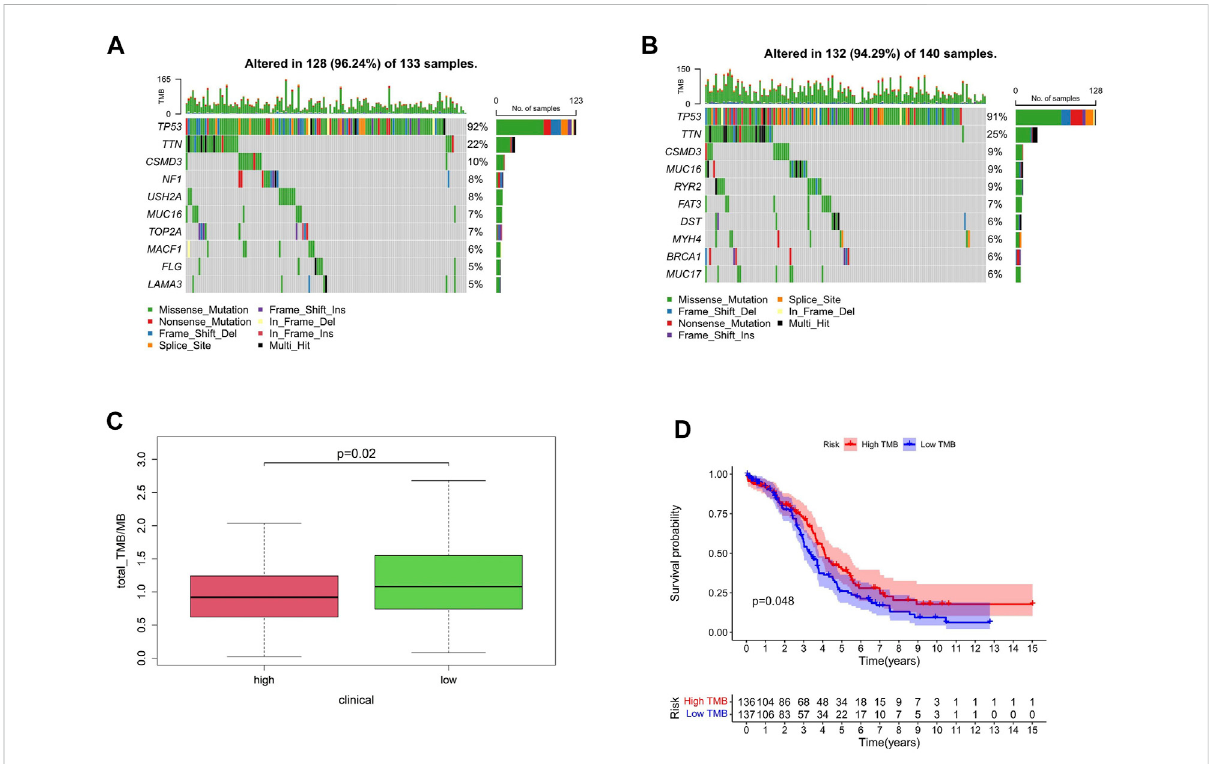
FIGURE 7 Mutation pro fi le and HAM risk groups. (A,B) Mutation pro fi les of high- and low-risk groups. (C) TMB differences between high- and low-risk groups. (D) Correlation between TMB and